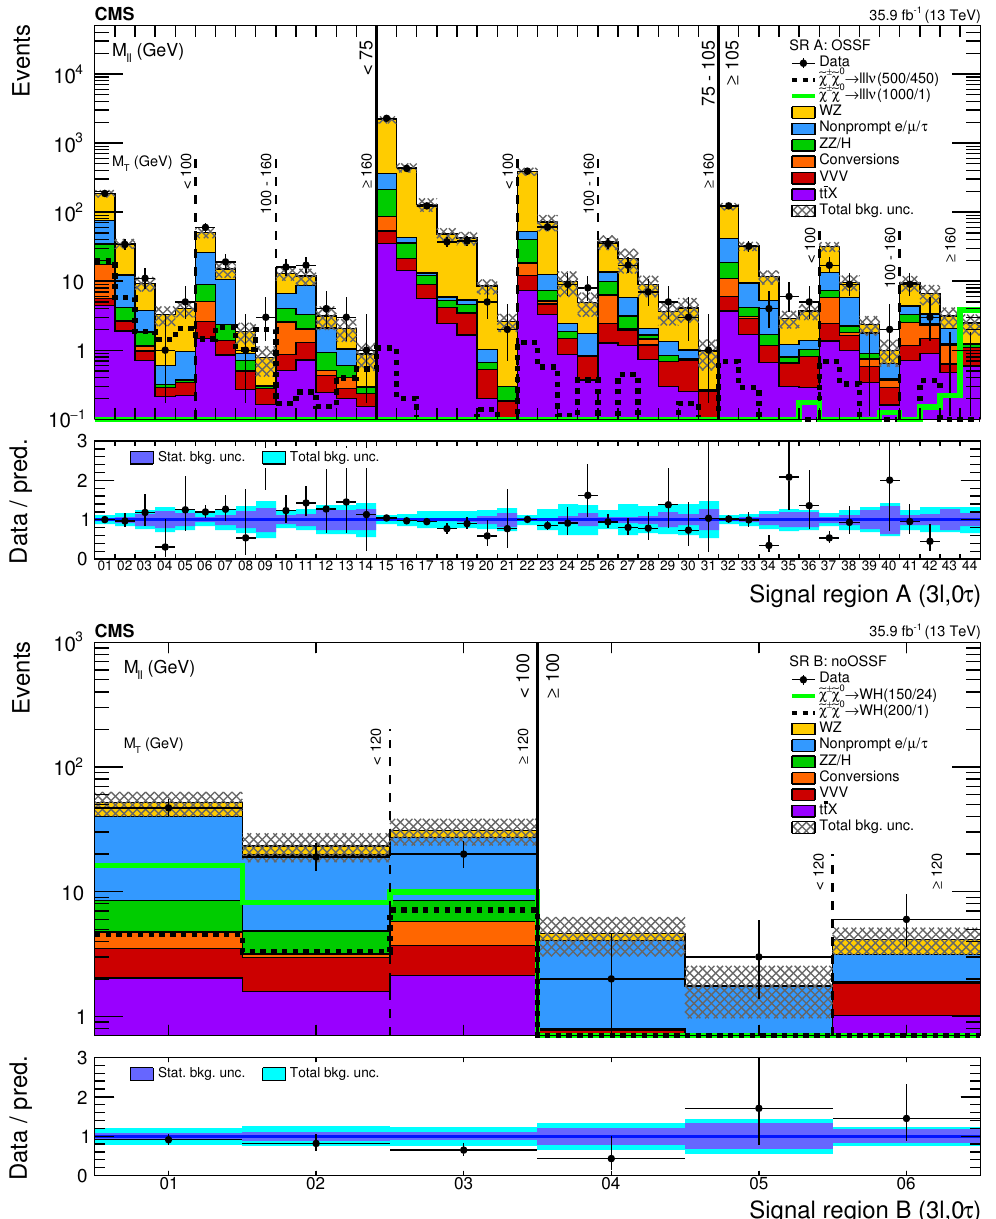
Figure 9 . Expected and observed yields comparison in category A (upper) and category B (lower) signal regions, i.e. 3 light (cid:13)avor leptons including at least one OSSF pair (A) or no OSSF pair (B). SR A15 is replaced by the WZ control region in interpretations of the results. Two signal mass points in the (cid:13)avor-democratic model with mass parameter x = 0 : 5 are displayed for illustration. The notation is analogous to that used in (cid:12)gure 4.